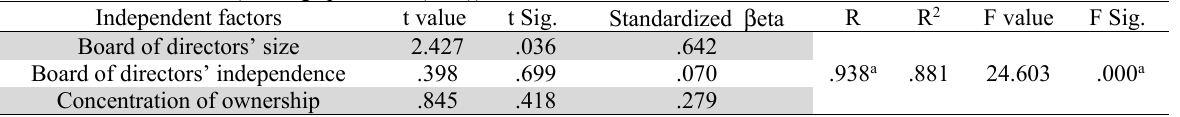
Results of multiple regression to test the impact of applying the principles of institutional governance (board of directors’ size, board of directors’ independence, concentration of ownership) on the accounting disclosure of service companies in Jordan with the indicator (earnings per share (EPS)) Independent factors value